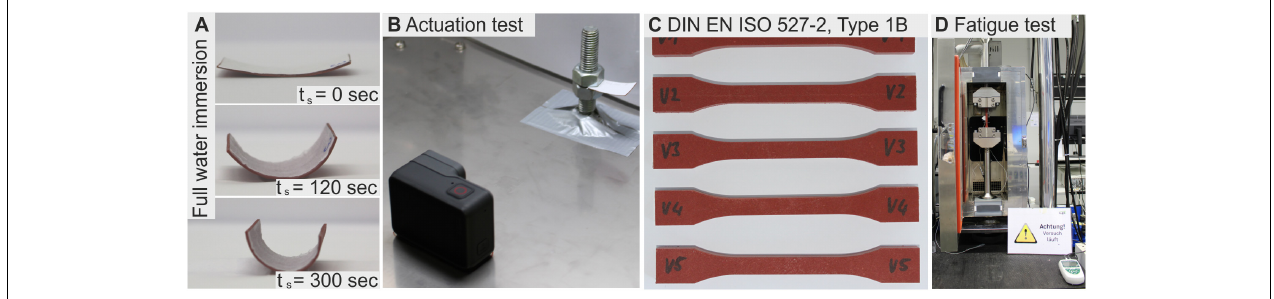
FIGURE 1 | (A) Full water immersion of Cottonid/paper bilayer actuator, (B) Optical monitoring of actuation performance, (C) Cottonid specimens for fatigue testing, (D) Test set up for fatigue testing.